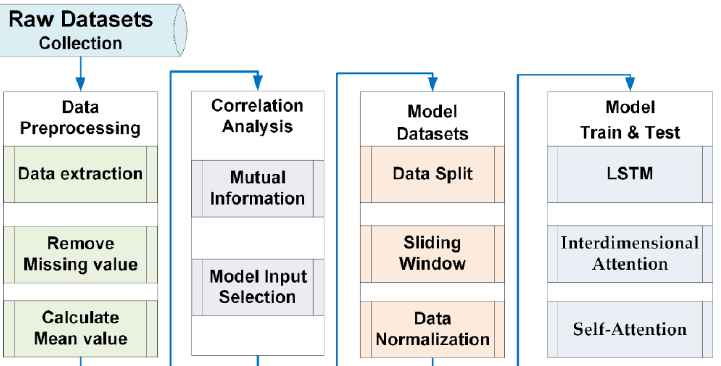
Figure 1. General flow chart of SST prediction based on a hybrid model combining LSTM and at- tention.